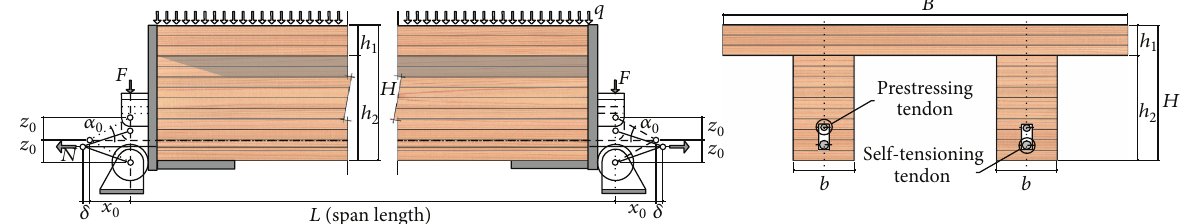
Figure 1: Multiplier device using a system of rods and 𝜋 -shape cross section of structural